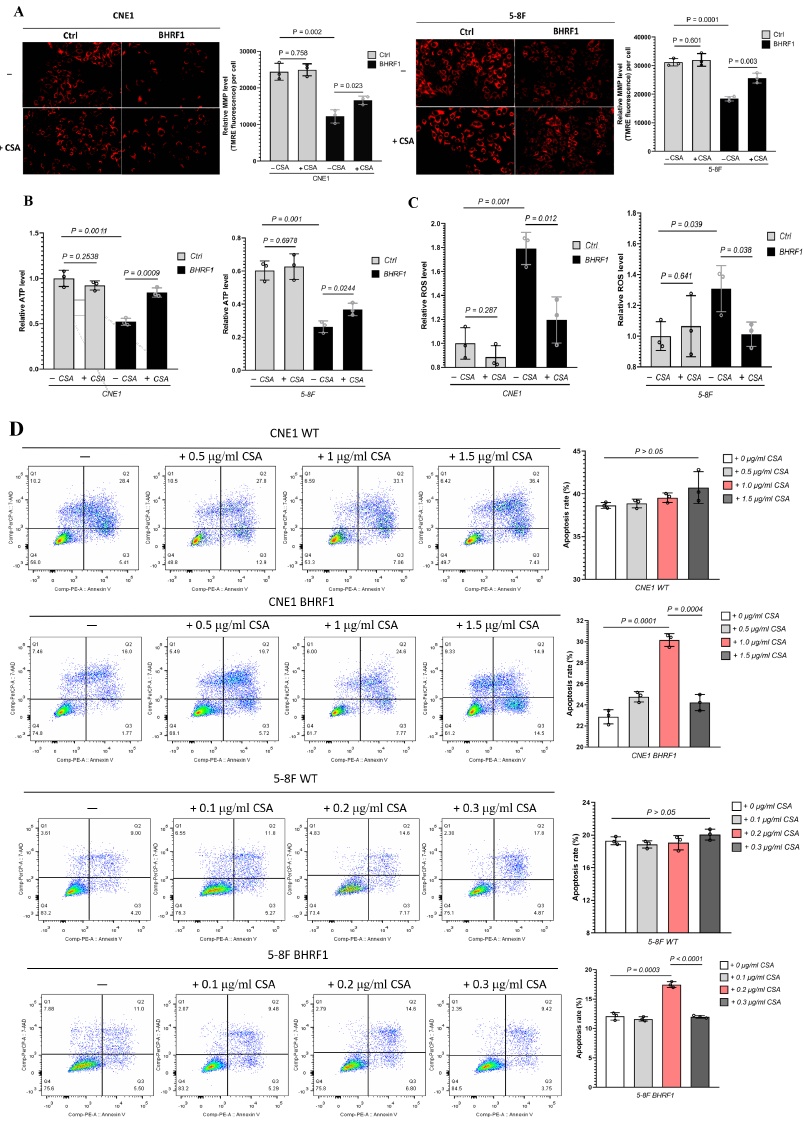
Figure 5. BHRF1 regulation is mediated through MMPT. ( A ), Representative images for assessment of MMP by TMRE for NPC cell lines treated with CSA; ( B ) and ( C ), ATP production or ROS generation in control cells and BHRF1 high expression cells treated with CsA. ( D ), The apoptosis rate of NPC cell lines with gradient concentration of CsA by flow cytometry. Data represent mean ± SE of three independent